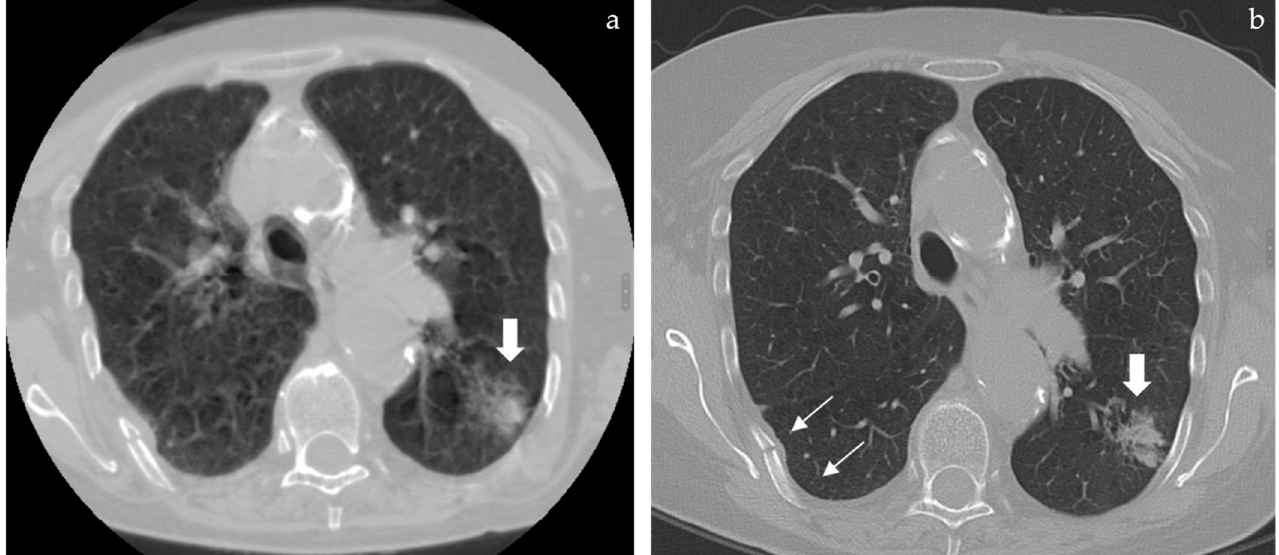
Figure 2. ( a ) ( left ) and ( b ) ( right ): whenever a lung opacity is spotted by chance in spine CT a full FOV reconstruction can be performed but only if RAW data are still available in the scanner. In the case (previously described in Figure 1) this allowed us to rule out further opacities but the respiratory motion artifacts prevented a proper characterization of the main lung finding that appeared as a blurry edged opacity ( a , large arrow). The patient was called back and a standard thoracic CT was repeated to better define the lung finding that appeared as a subsolid ground glass opacity compatible with a lepidic growth adenocarcinoma ( b , large arrow) as later confirmed by lung biopsy. In both full FOV reconstructions a rib fracture was detected ( b , thin arrows).